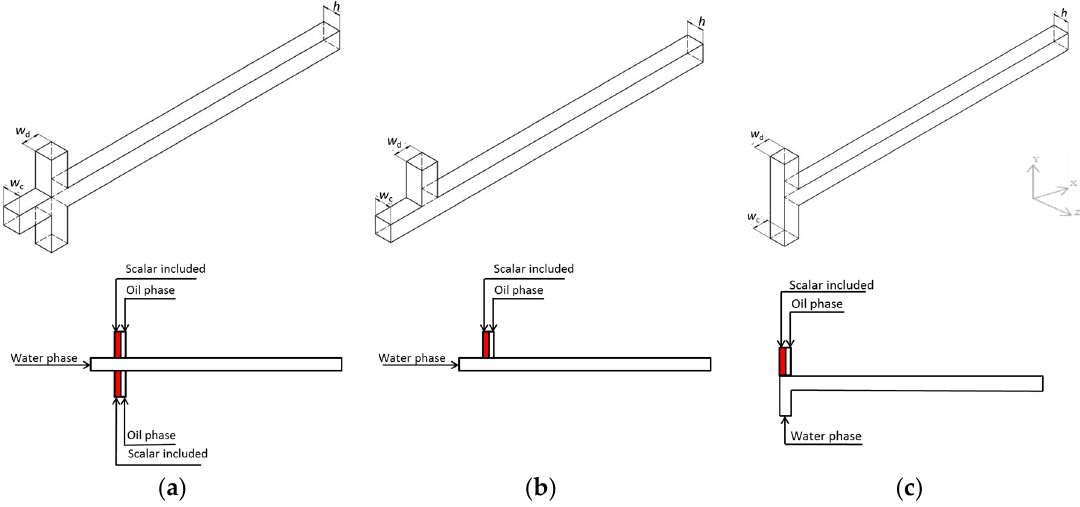
Figure 1. Schematic diagram of the microchannel. w c = w d = h = 100 μ m. ( a ) Cross-shaped junction; ( b ) Cross-shaped T-junction; ( c ) T-junction. Table 1. Physical properties of the continuous phase and the disperse phase.